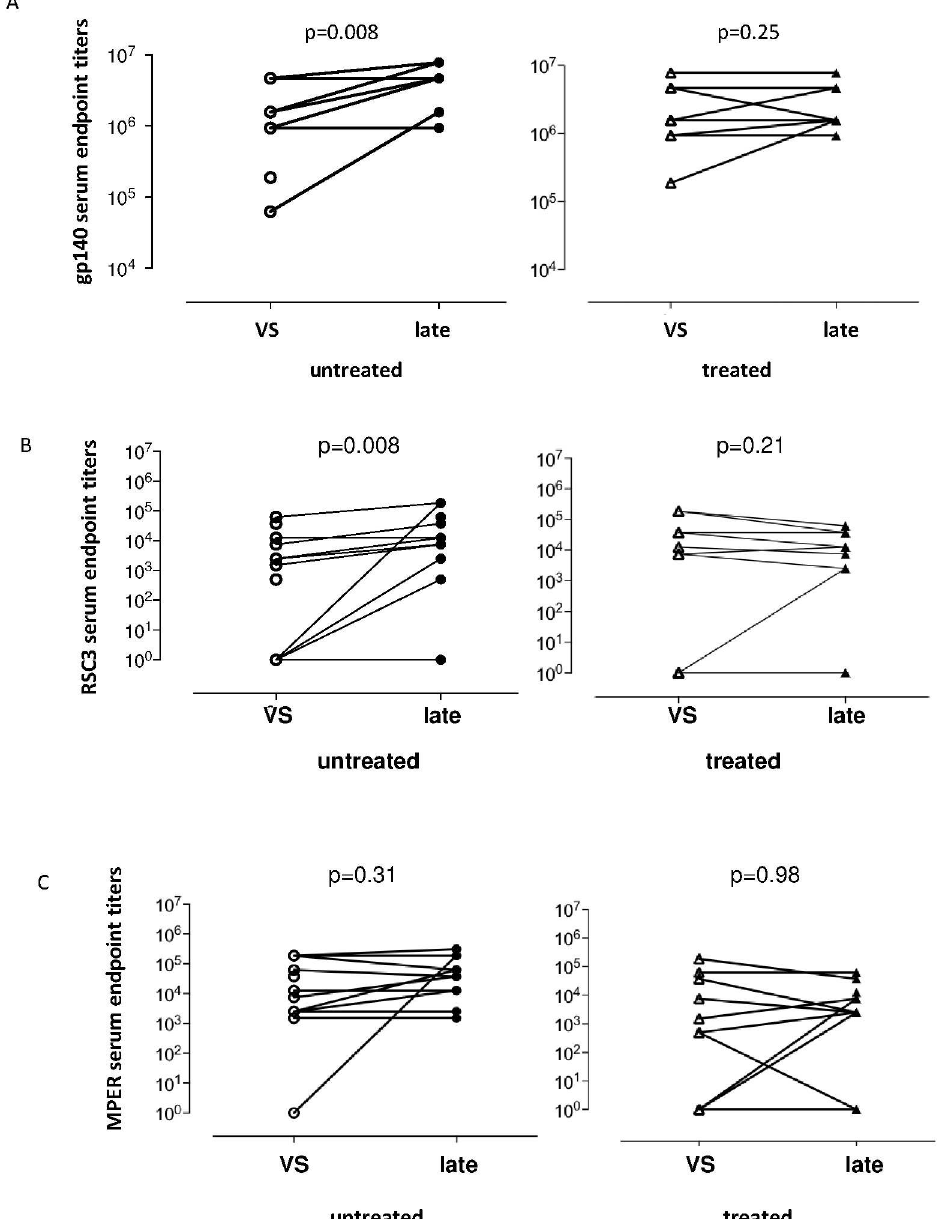
Fig 6. Scatterplots showing the serum endpoint titers of antibodies directed againstgp140 ( A ), CD4 bindingsite (CD4bs) (resurfacedstabilizedgp120core (RSC3))( B ) and membraneproximal region(MPER) ( C ) in untreated (left panels) and treated (right panels) patients at viral set point (VS) and at the late time point (late). Statistical significancewas calculatedwith nonparametric Wilcoxon matched-pairs signed-ranks test.